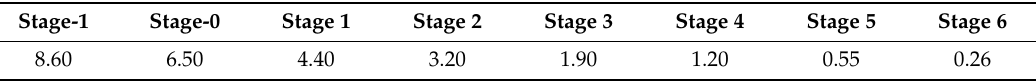
Table 1. Cut-o ff aerodynamic diameter ( µ m) for stages of Andersen cascade impactor (ACI) used at 60 L /